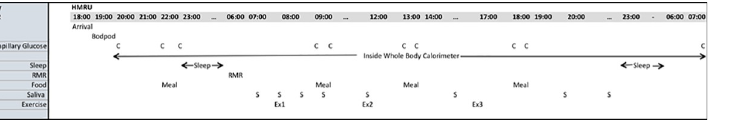
Fig 1. The protocol for the measurements in the metabolic chamber. It should be noted that the capillary blood sampling (C) and the saliva sampling (S) were both carried out by the